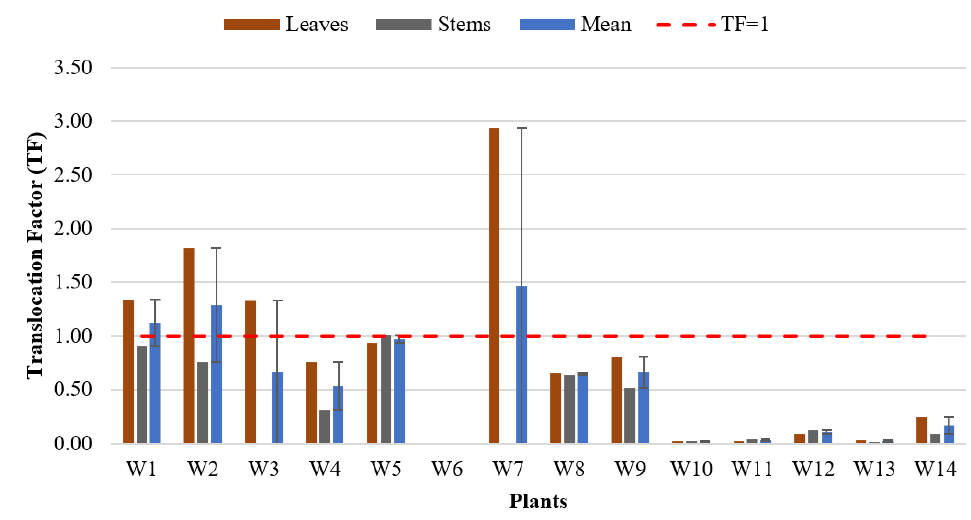
Figure 8. Translocation factor (TF) of iron (Fe) in the phytoremediation of domestic sewage meso- cosms using various tropical plants.